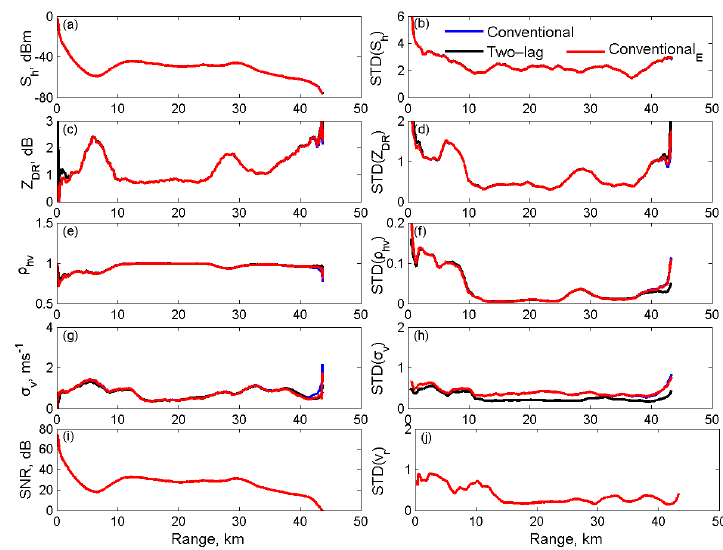
Figure 5. Comparison between conventional estimators and two-lag estimators for radial B. Four rows show S h , σ v , Z DR , ρ hv and their standard deviation, respectively. The SNR and standard deviation of v r are given in the fifth row. ( a ) S h ; ( b ) STD(S h ); ( c ) Z DR ; ( d ) STD(Z DR ); ( e ) ρ hv ; ( f ) STD( ρ hv ); ( g ) σ v ; ( h ) STD( σ v ); ( i ) SNR; and ( j ) STD(v r ).